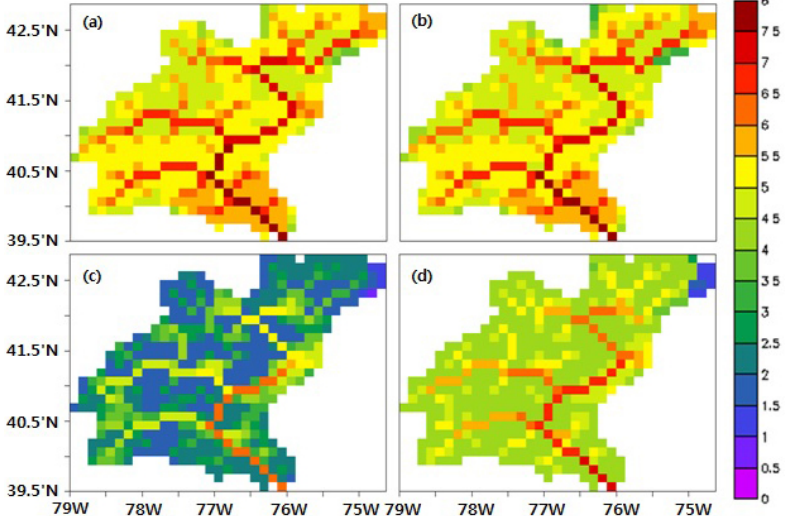
Figure 7. Spatial distribution maps of 20year (1986–2005) average simulated stream (a) dissolved N, (b) nitrate N, (c) ammonium N, and (d) dissolved organic N loads, log(kgyear − 1 ).